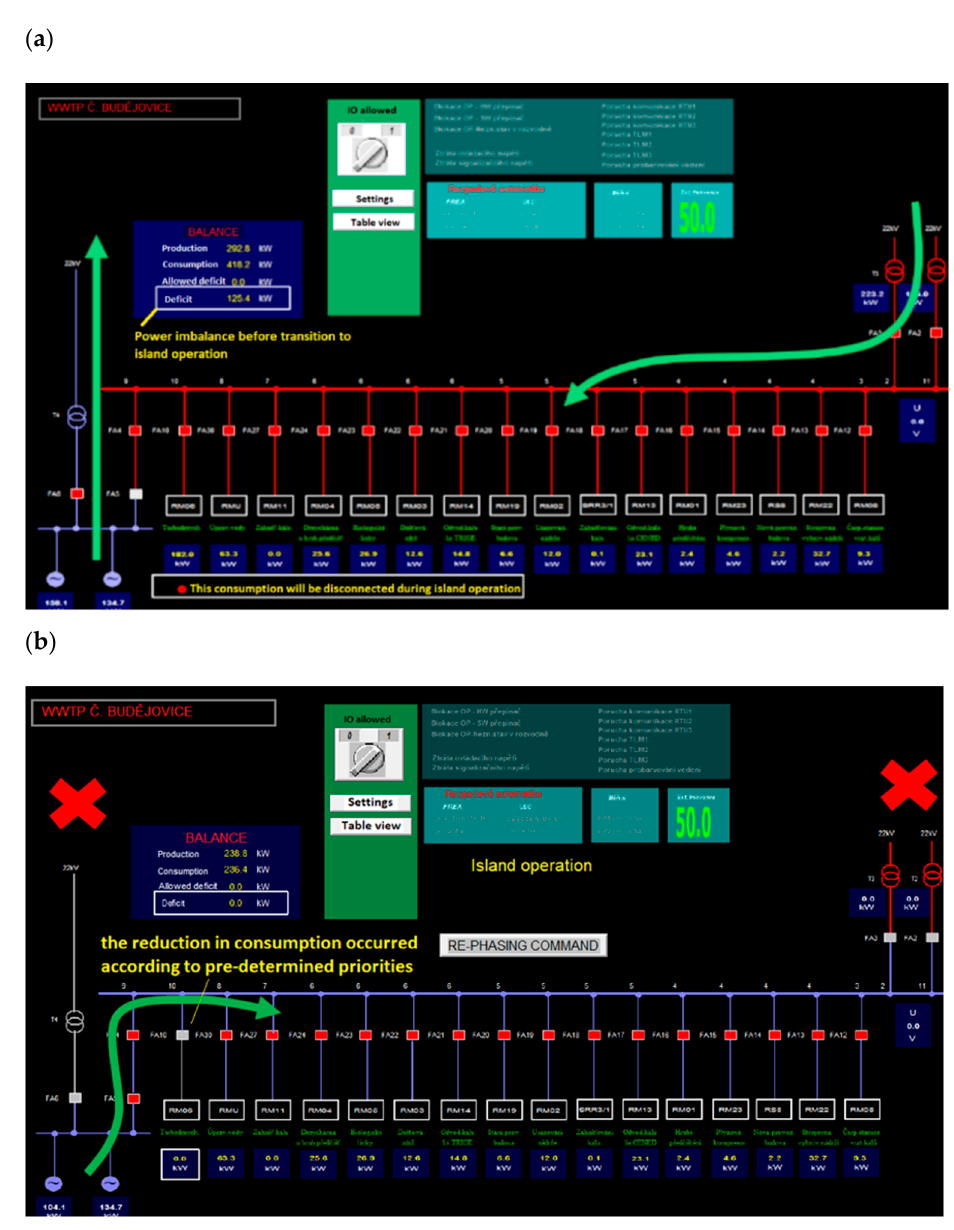
Figure 10. Control system screen during: ( a ) normal and ( b ) island operation of a WWTP [39].